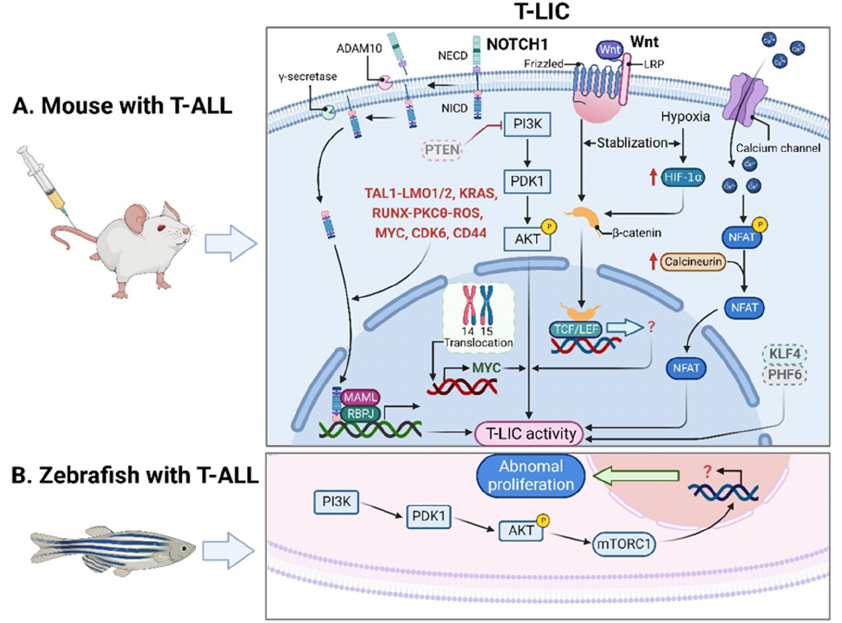
Figure 1. T-LICs in animal models. ( A ) The formation and maintenance of T-LICs involve multiple genetic and molecular events, independent or in cooperation with NOTCH1. Briefly, NOTCH1 acts as a ligand-activated transcription factor. The ligand–receptor interaction triggers the cleavage of the NECD by ADAM10 metalloproteases, followed by the subsequent NICD cleavage by γ - secretases. Once released from the membrane, the cytoplasmic NICD translocates into the nucleus, where it activates gene transcription via association with RBPJ DNA-binding protein and MAML transcriptional co-activator. NOTCH1 also modulates T-LIC activity by cooperating with TAL1- LMO1/2, KRAS, RUNX-mediated PKC θ and ROS, MYC, CDK6, or CD44. On the other hand, inactivation of PTEN-induced PI3K-AKT activation, together with the subsequent activation of β - catenin, as well as the aberrant overexpression of MYC induced by t (14;15) translocation, contributes to the onset of T-ALL independent of NOTCH1. Specifically, the binding of Wnt ligand to its receptor Frizzled and/or LRP leads to the activation of Wnt signaling, which stabilizes β -catenin from degradation. Further translocation of β -catenin into the nucleus promotes the downstream gene transcription by binding to TCF/LEF. Finally, the maintenance of T-LIC activity also requires active HIF1 α protein, which supports Wnt signaling by promoting accumulation of β -catenin proteins. Activation of calcineurin/NFAT signaling is also critical for T-LIC activity, and the same holds true for the inactivation of KLF4 or PHF6. ( B ) The increased frequency of T-LICs in zebrafish models might be caused by the abnormal activation of AKT-mTORC1 signaling. ADAM10, a disintegrin and metalloprotease 10; AKT, AKT serine/threonine kinase; CDK6, cyclin dependent kinase 6; HIF1 α , hypoxia-induced factor 1 alpha; KLF4, Krüppel-like factor 4; KRAS, KRAS proto-oncogene; LEF, lymphoid enhancer-binding factor; LMO1/2, LIM domain only 1/2; LRP, lipoprotein-receptor-related protein; MAML, mastermind-like; mTORC1, mechanistic target of rapamycin kinase complex 1; MYC, MYC proto-oncogene; NECD, NOTCH extracellular domain; NFAT, nuclear factor of activated T cells; NICD, NOTCH intracellular domain; NOTCH1, notch receptor 1; PHF6, plant homeodomain factor 6; PI3K, phosphatidylinositol 3-kinase; PKC θ , protein kinase C theta; PTEN, phosphatase and tensin homolog; RBPJ, recombination signal binding protein for immunoglobulin kappa J region; ROS, reactive oxygen species; RUNX, runt-related transcription factor; TAL1, T-cell acute lymphocytic 1 (TAL) basic helix-loop-helix (bHLH) transcription factor 1; T-ALL, T-cell acute lymphoblastic leukemia; TCF, T-cell factor; T-LICs, T-ALL leukemia-initiating cells; Wnt,